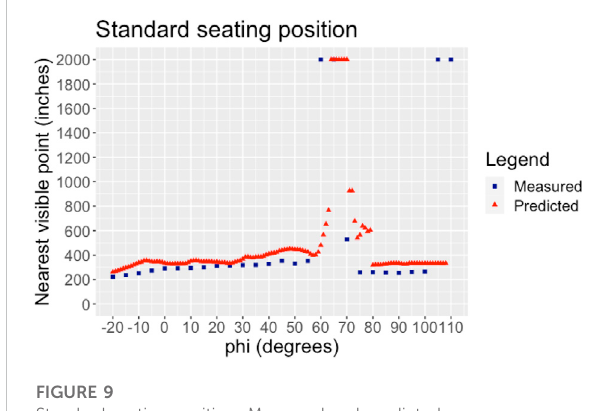
FIGURE 9 Standard seating position: Measured and predicted.